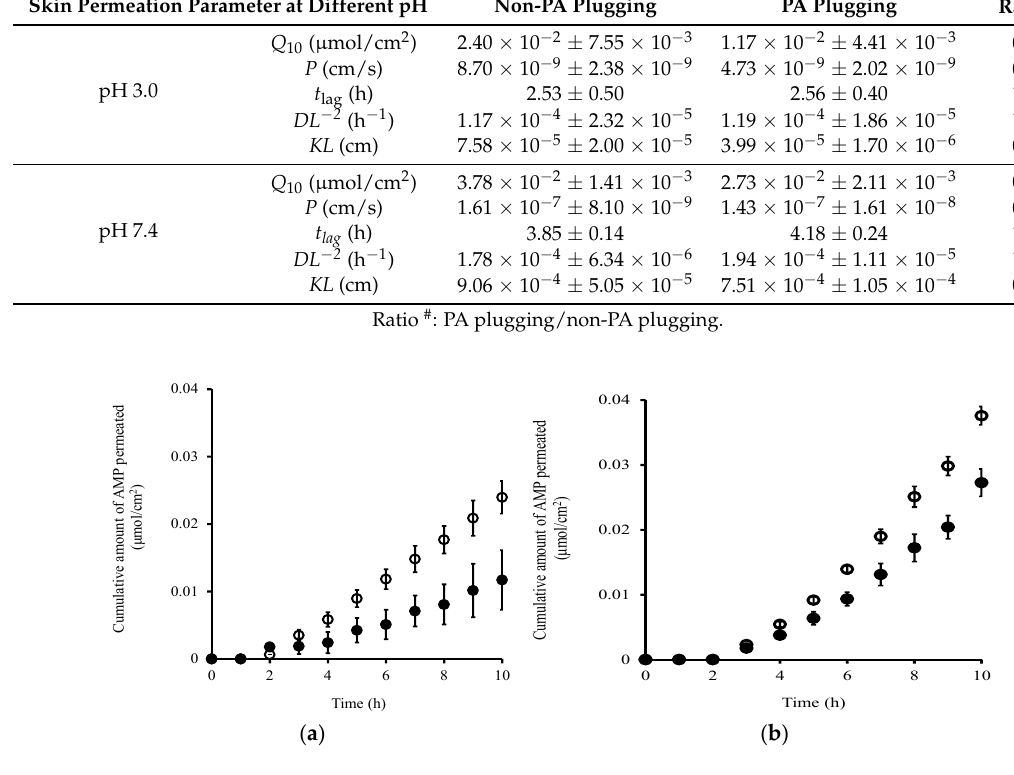
Figure 3. Time course of the cumulative amount of AMP that permeated through pig ear skin at pH 3.0 ( a ) and pH 7.4 ( b ). Non-hair-follicle-plugged skin ( ), hair-follicle-plugged skin ( ). Each point represents the mean ± S.E. ( n = 4).